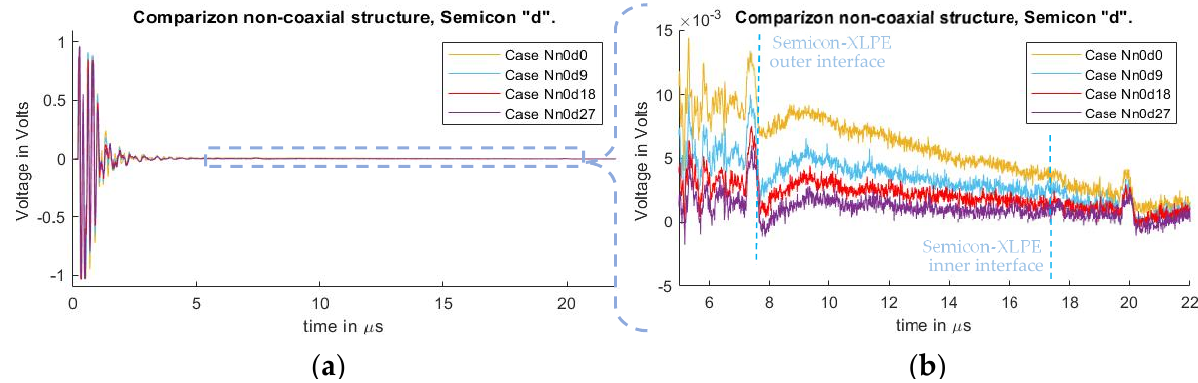
Figure 6. Measured disturbance for cases with different distances “ d ” for non-coaxial injection. ( a ) Full measured signal ranging from the instant of the pulsed voltage application up to 22 µ s. ( b ) Focus on the time instant of the acoustic signal arrival belonging to the charge measurements.